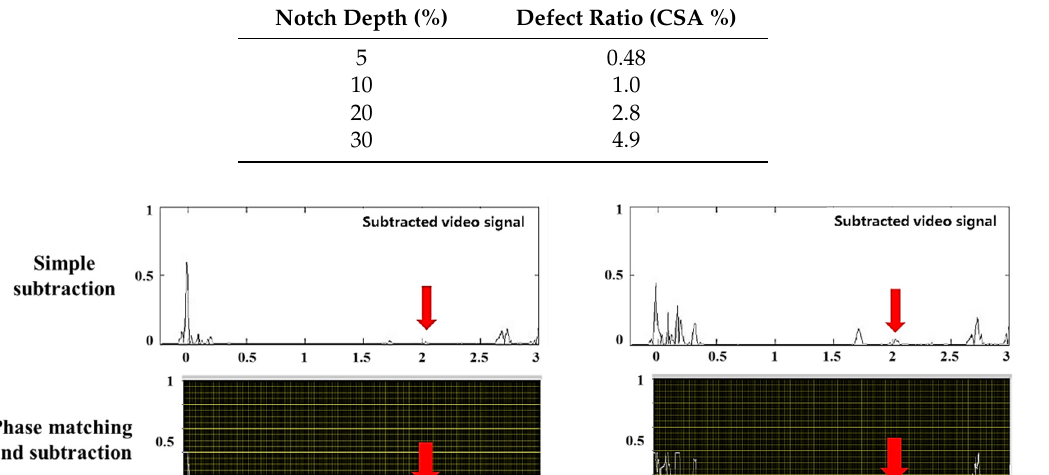
Table 1. Notch depth to pipe wall thickness and notch area to the CSA of pipe at the weld region.